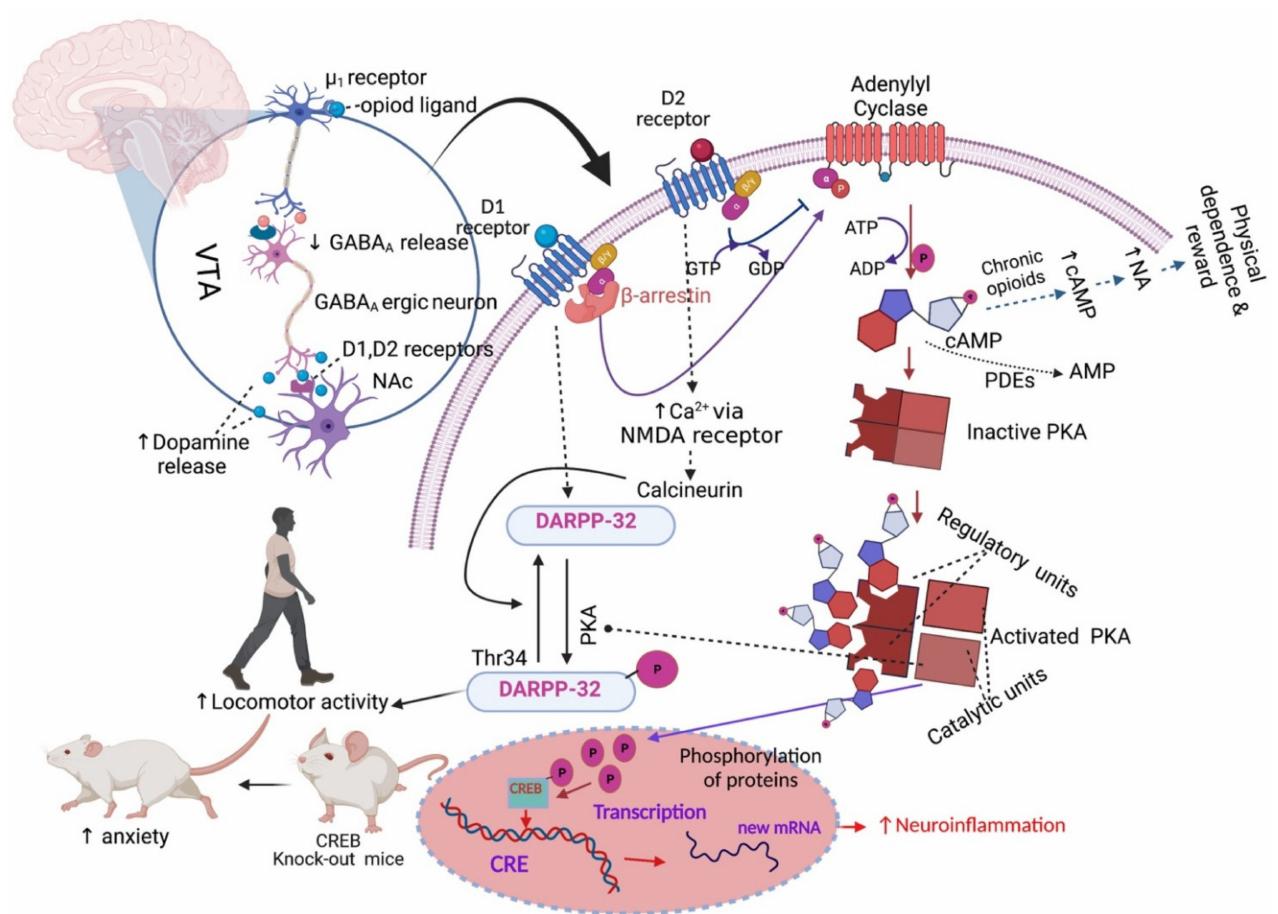
Figure 2. Effects of opioids on motor behaviour. Abbreviations: GABA, gamma-aminobutyric; cAMP, cyclic adenosine monophosphate; PKA, protein kinase A; CRE, cAMP-responsive element; CREB, cAMP-responsive element binding protein; D1, dopamine receptor-1; DARPP-32, dopamine- and cAMP-regulated phosphoprotein of 32 kDa; NMDA, N -methyl- D - aspartate receptor; PDEs, Cyclic nucleotide phosphodiesterases; NA, noradrenaline, VTA, ventral tegmental area; NAc, nucleus accumbens. Symbols: solid arrow, strong activation; dashed arrow, moderate activation; solid T-shaped line, strong inhibition; dashed T-shaped line, moderate inhibition, upward arrow, increased effect; downward arrow, decreased effect. The figure was made with www.biorender.com (accessed on 19 October